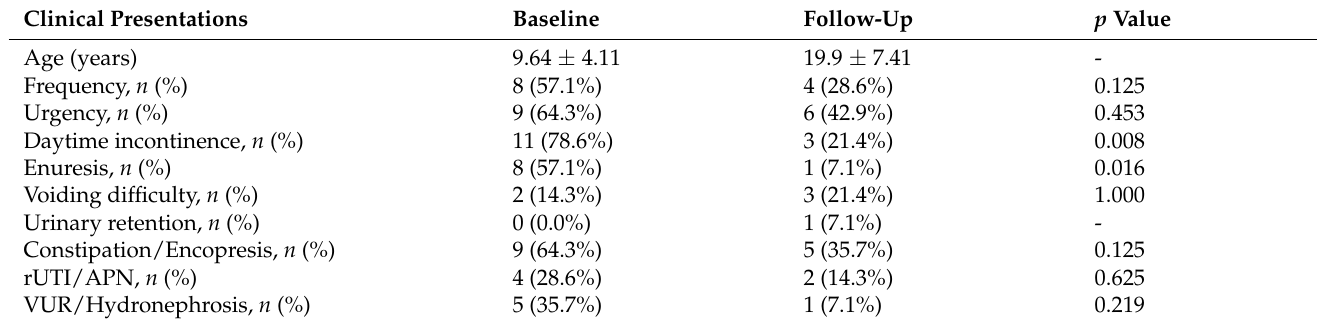
Table 3. Clinical presentations of 14 patients with dysfunctional voiding at baseline and long-term